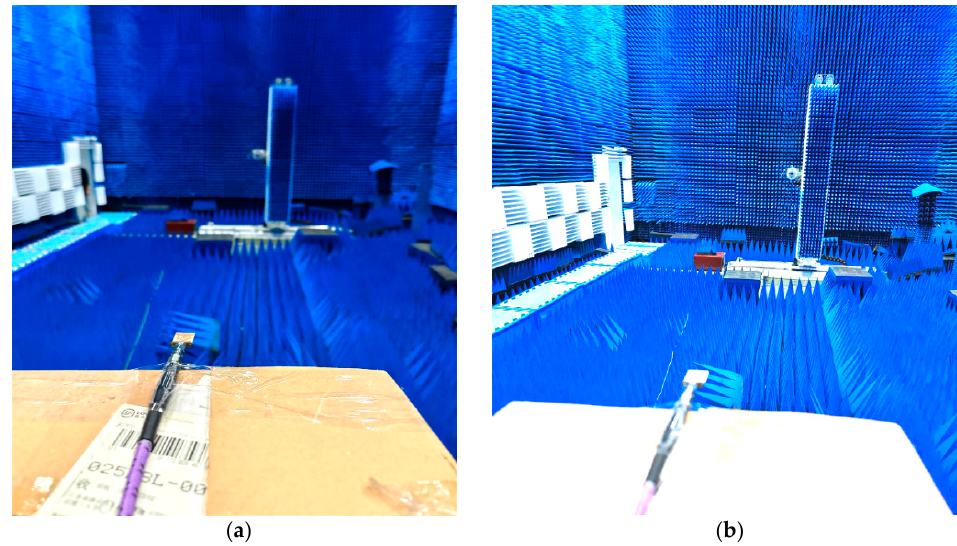
Figure 11. (a, b) Antenna under test (AUT) environment of anechoic chamber.